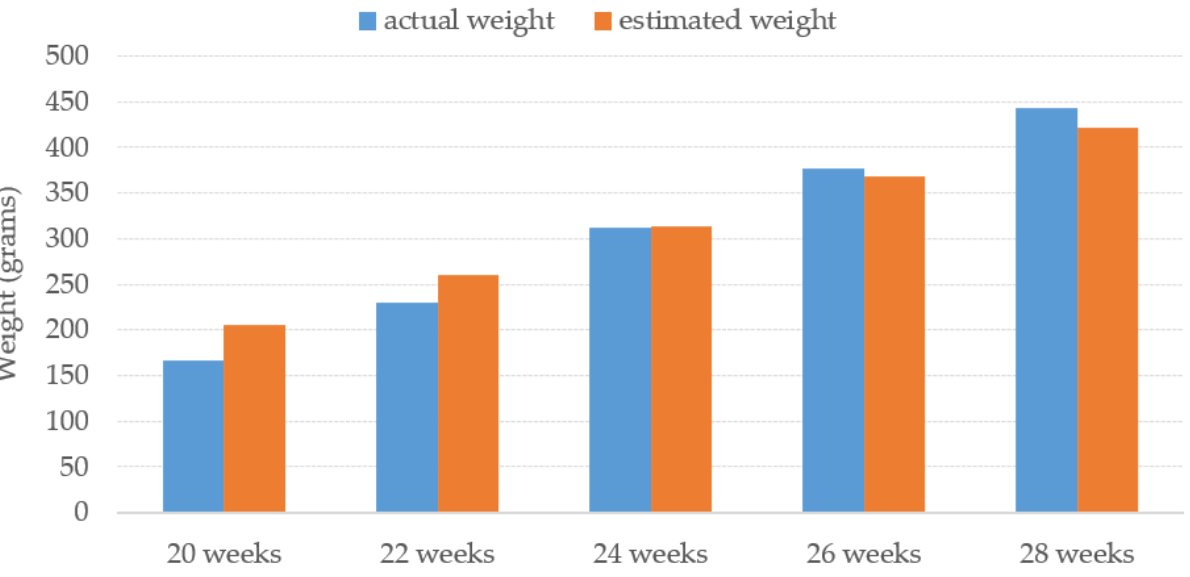
Figure 14. Proposed TWE-DRL performance presents average estimated weight of Tilapia with various age in turbid